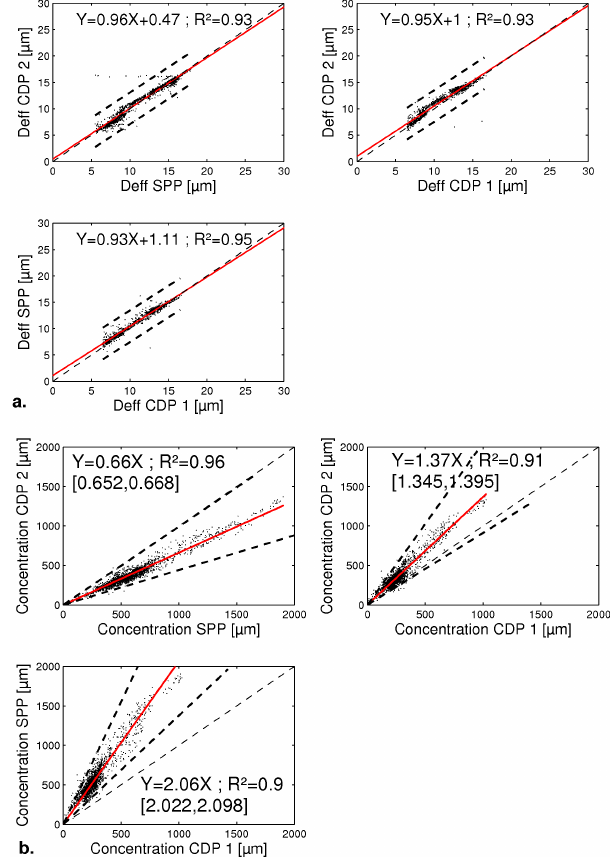
Figure 7. (a) Ten second averaged data comparison of the effective diameter measured by the instruments installed in the wind tunnel, i.e., the CDP1, the CDP2 and the SPP; and (b) 10s averaged data comparison of the concentration measured by the instruments in- stalled in the wind tunnel. The confidence intervals with a confi- dence level of 99% are given in square brackets. The bold dashed lines show the instrumental errors applied to the fits.